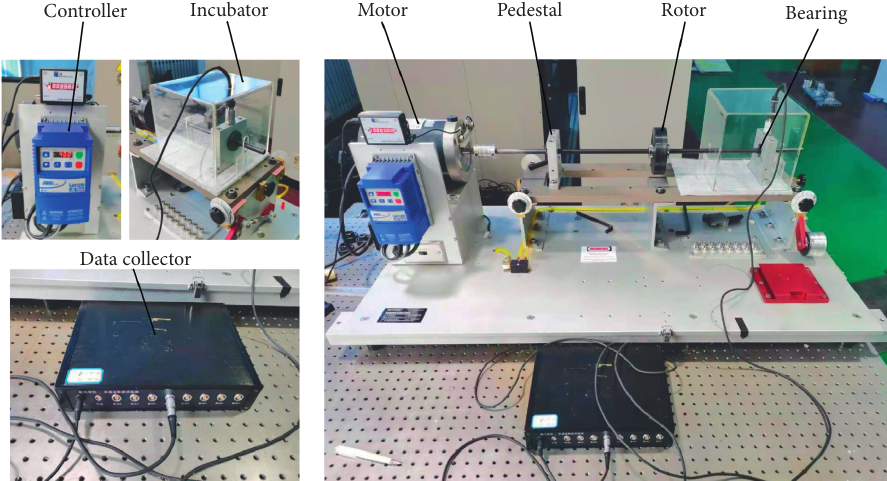
Figure 10: Test rig used in the experiment.